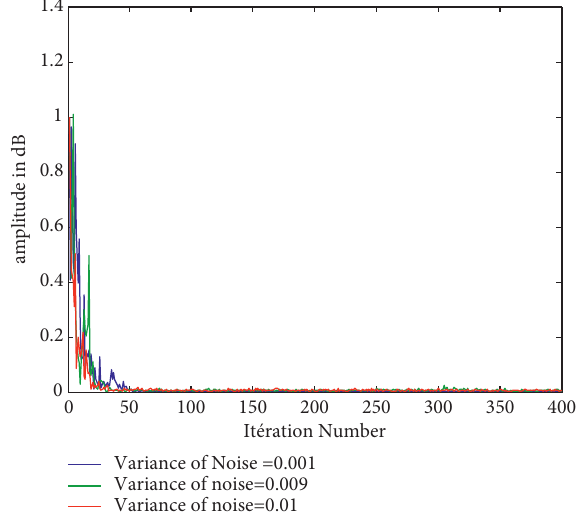
Figure 7: Effect of noise on LMS capacity.